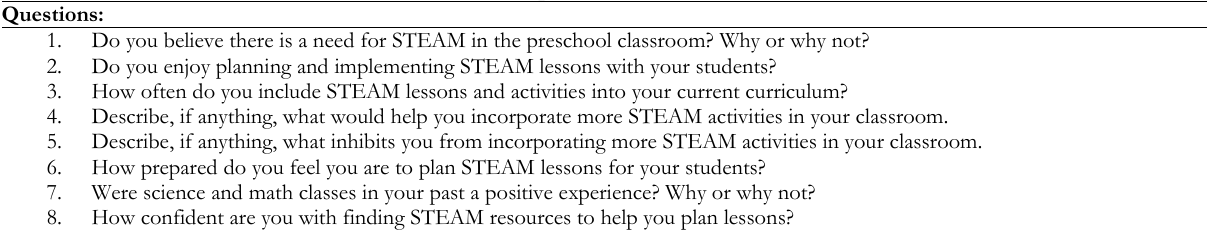
Table 2. Interview Questionnaire of Teachers’ Experiences with STEAM Instruction Questions: